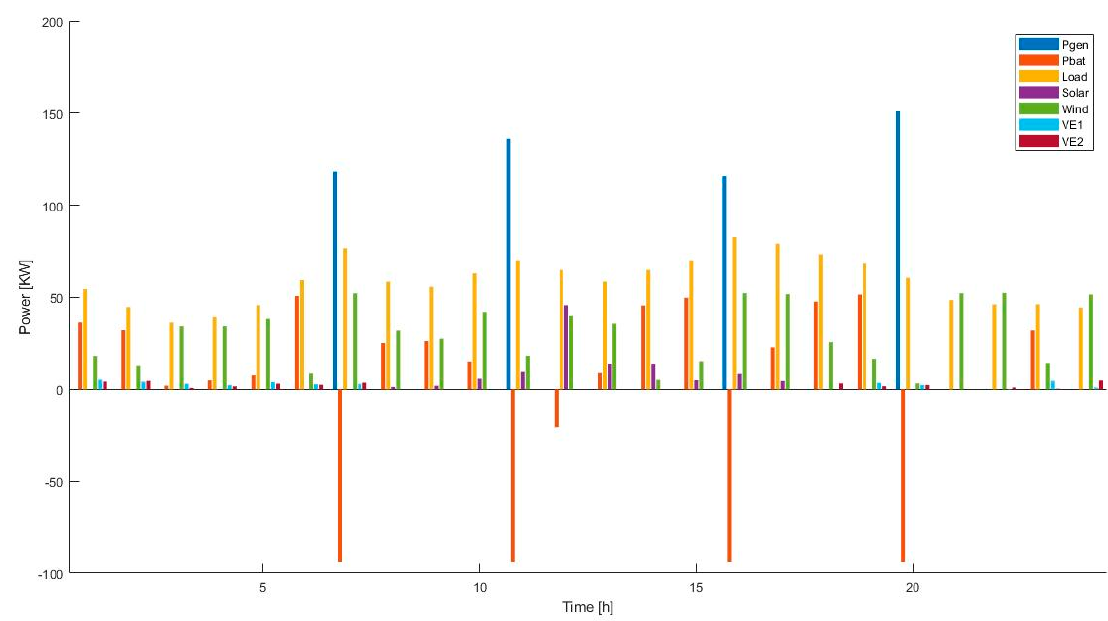
Figure 1. Microgrid (MG) operation during 24 hours when the system is new. Energies 2020 , 13 , 957